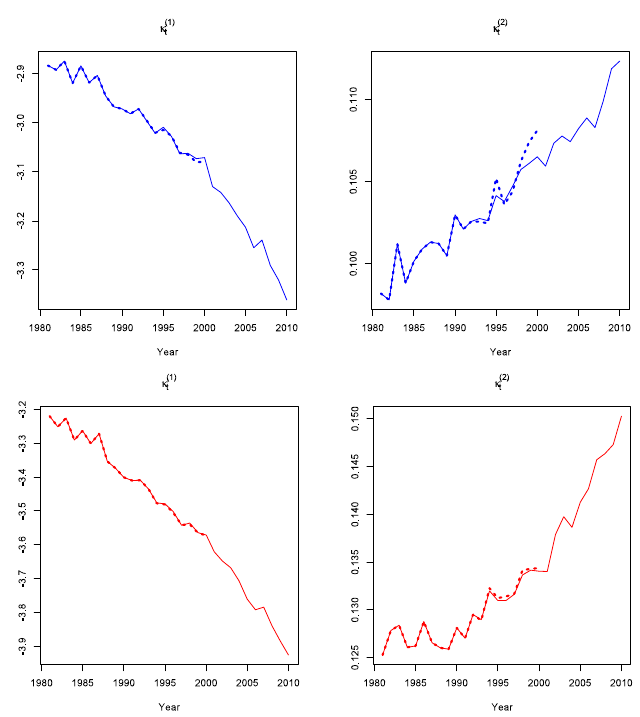
( 1 ) ( 2 ) Figure 5. M 5 : κ and κ estimated parameters for males ( top panels) and females ( bottom panels), t t aged 60–89, fitted in 1981–2010 (solid lines) and 1981–2000 (dotted lines).